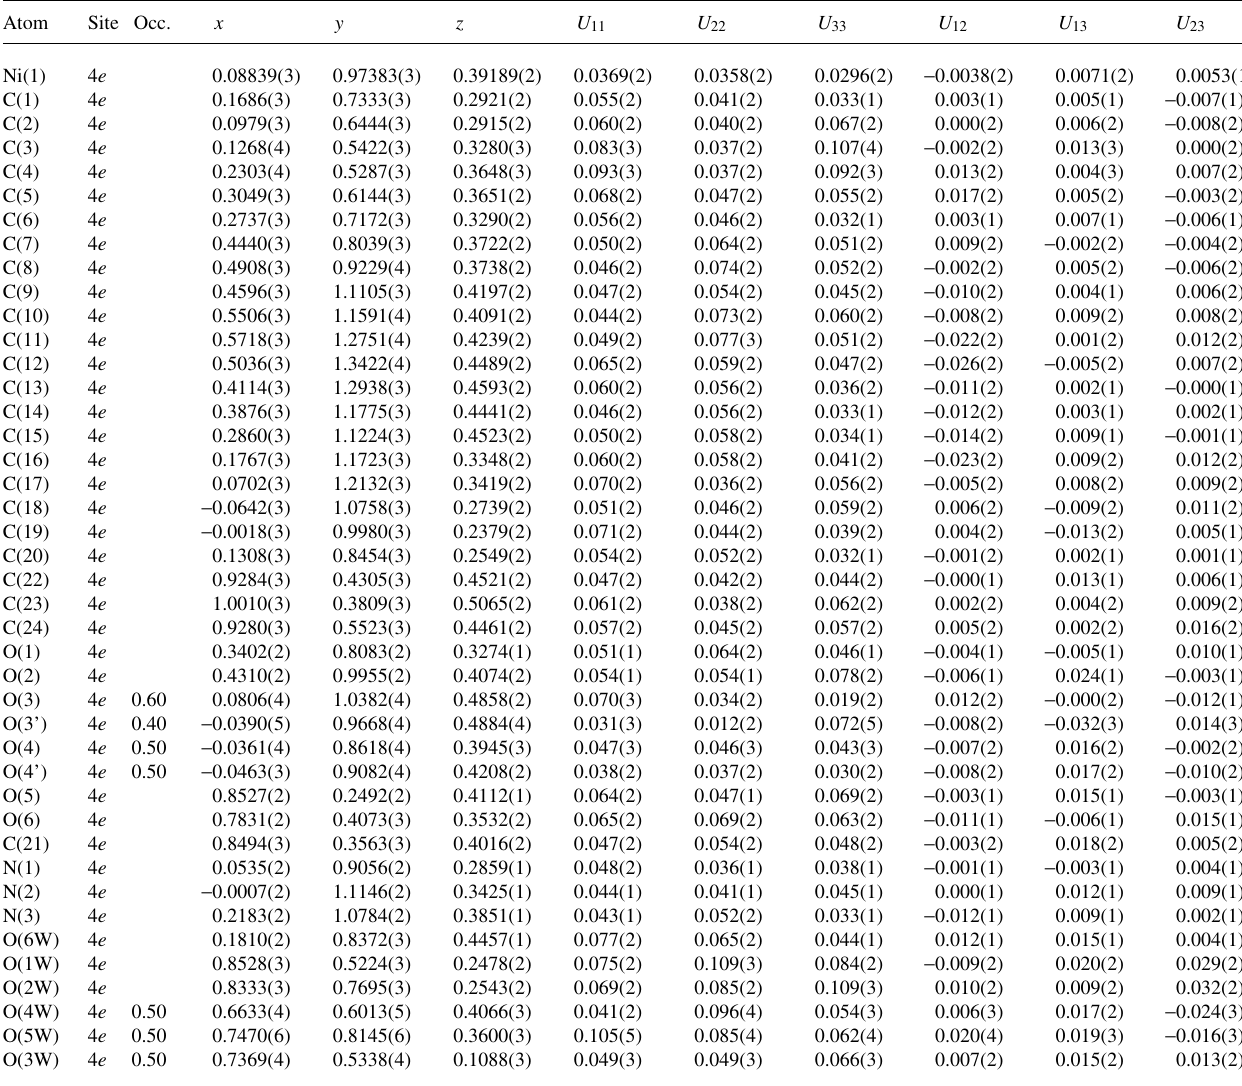
Table 3. Atomic coordinates and displacement parameters (in Å 2 )